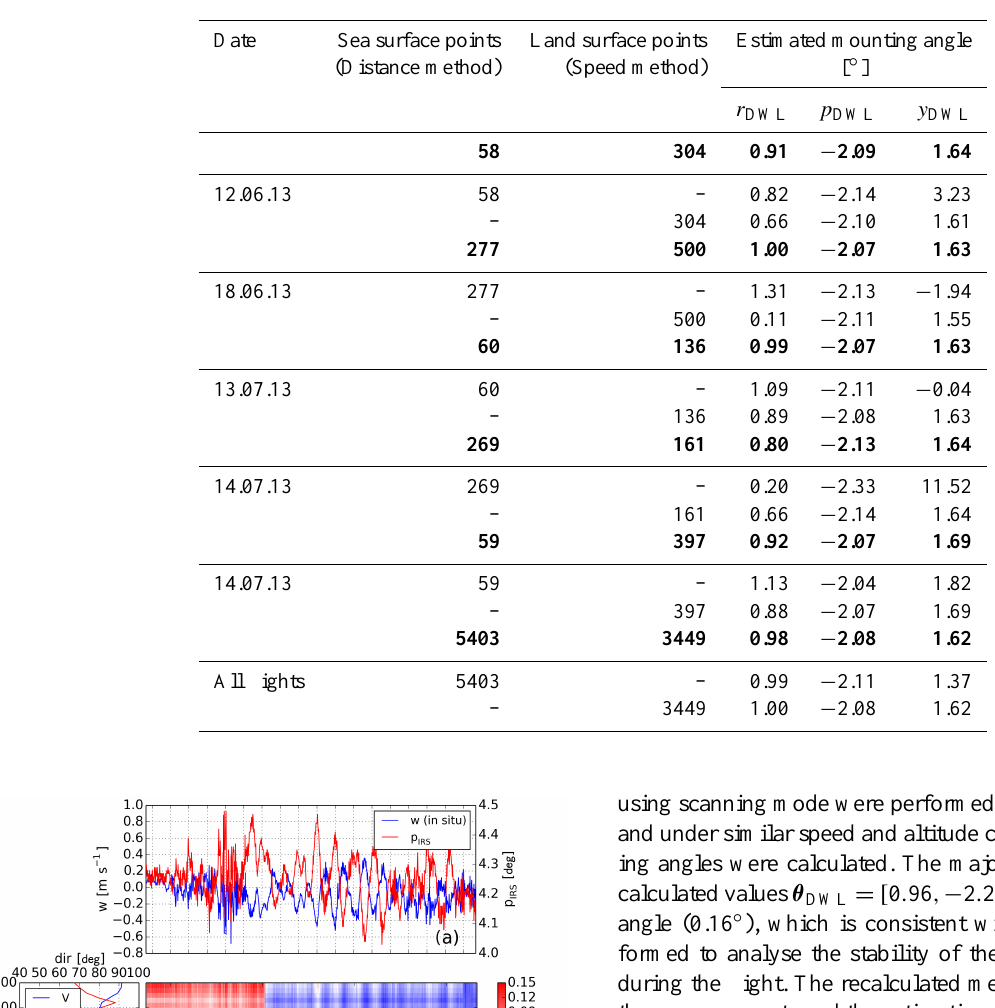
Table 2. Estimated lidar mounting angles. The first row of each flight corresponds to the retrieved mounting angle using distance and speed measurements, while the second and third rows correspond to the use of only distance or speed respectively.